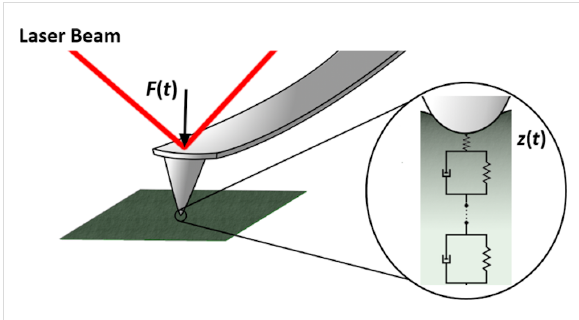
Figure 2: Illustration of the classical force–distance experiment. The AFM cantilever tip approaches and indents the sample under off-reso- nance conditions, while the force and indentation are calculated with respect to time with the aid of the probe position detection system (e.g., a laser beam detector). The most important assumptions in our linear viscoelastic analysis, which is described in subsequent sections, are that the sample is homogeneous and isotropic, and that the inden- tation is “small” with respect to the radius of curvature of the indenter. Large sample deformations lead to nonlinear material responses. Further experimental details are provided in the Methods